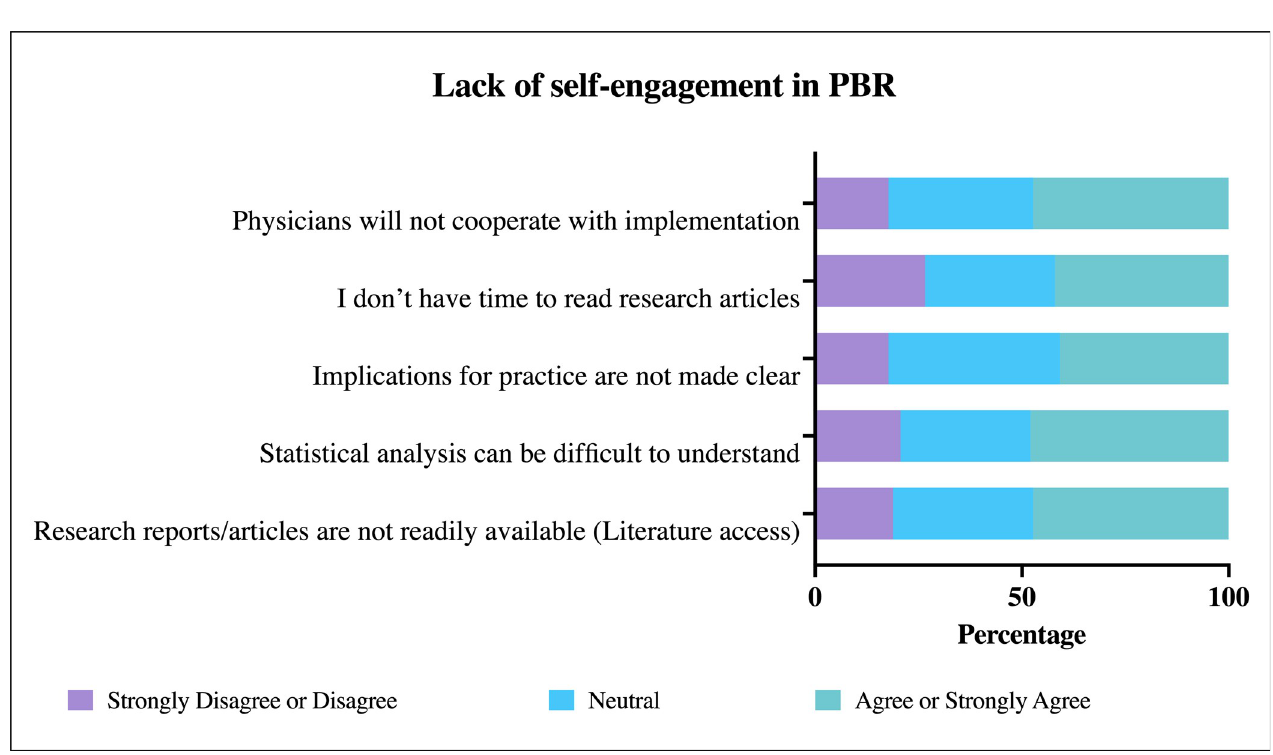
Fig 3. Item analysis of barrier C: Lack of self-engagement in (PBR).